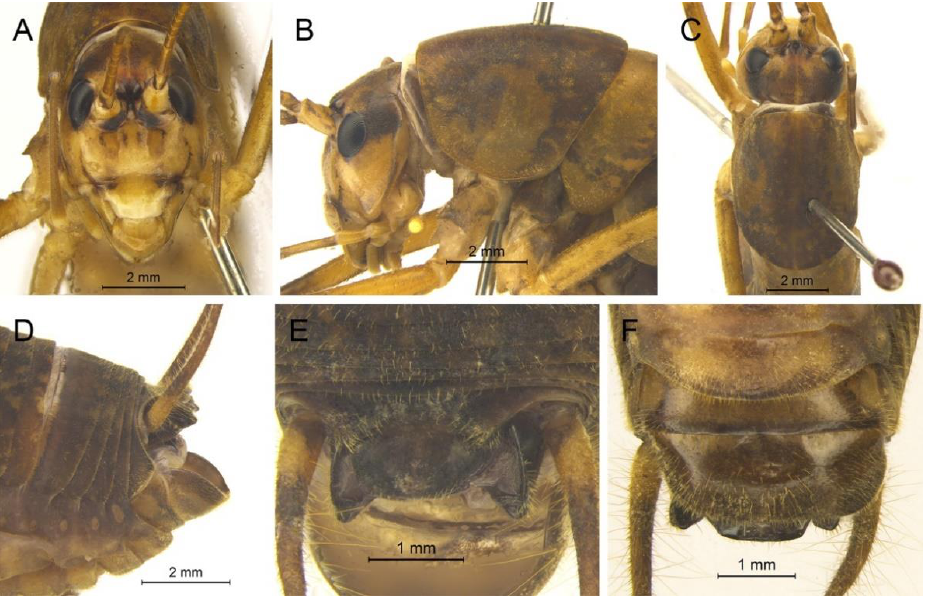
Figure 17. Homotachycines acutilobatus comb. nov., male: ( A – C ) head and pronotum: ( A ) frontal view, ( B ) lateral view, ( C ) dorsal view; ( D – F ) apex of abdomen: ( D ) lateral view, ( E ) dorsal view, ( F ) ventral view.